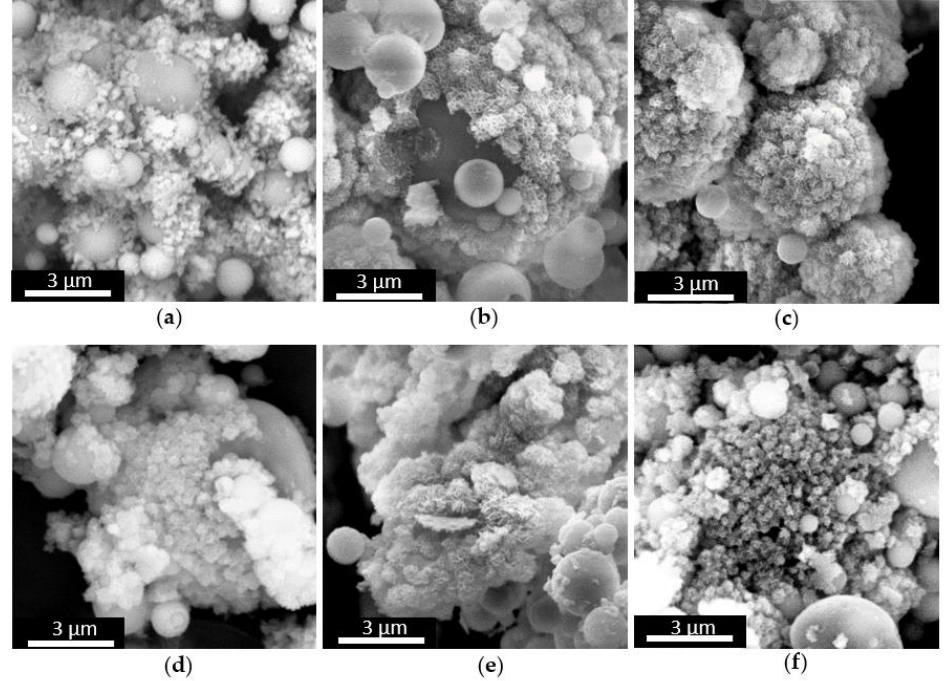
Figure 5. FESEM images and XRD spectra of MBG_Sr_SD after different time of soaking in SBF: